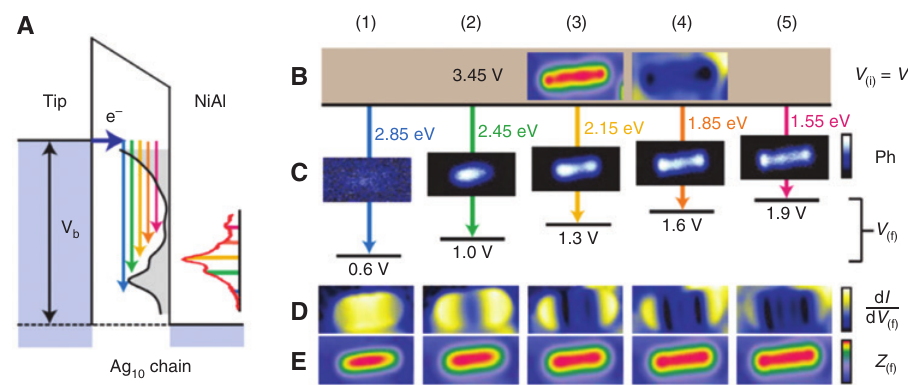
Figure 4: Spectroscopic mapping of the LDOS modification by introducing an Ag-chain in the tip sample junction. (A) Schematic representation of radiative transitions in an Ag chain, where electrons undergo transitions between the Ag chain states 10 (black d I /d V curve) and of the corresponding photon emission spectrum (red). Five vertical arrows of different colors show transitions into the LDOS of Ag . (B) Topography (left) and simultaneous d I /d V image at the initial state of all the transitions. (C) Photon maps for different 10 energies of transitions between the same initial state V to five different final states at V . The photon images show zero to four maxima. (i) (f) (D) d I/ d V images for the five final states showing the nodes (dark bands) for the ground state and the excited states of the particle in a box. The positions of the emission maxima in the photon maps coincide with the nodes in D. (E) Topographic images [ Z ] of the Ag10 chain at the (f) respective biases, from Ref. [93] reprinted with permission from